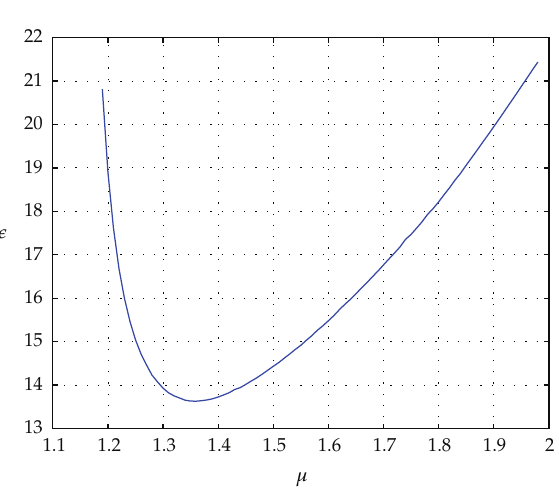
Figure 1: The local optimal bound of (cid:9)